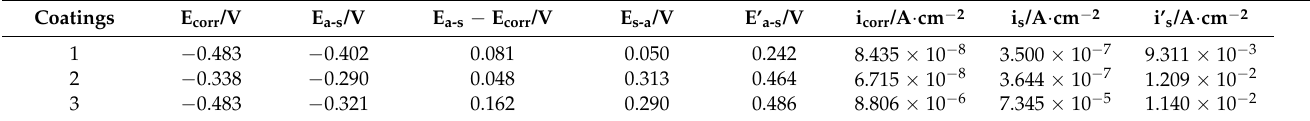
Table 5. Electrochemical parameters obtained from Figure 11.